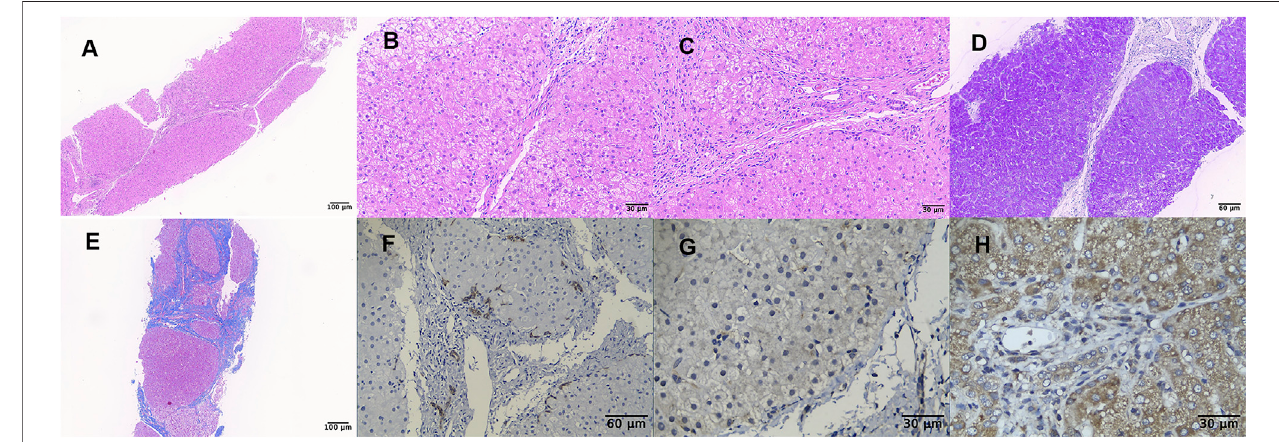
FIGURE 1 | Liver biopsy (all originally magni fi ed principal images). Hematoxylin and eosin staining showed the discorded architecture of liver lobules and the formation of pseudo-lobules (A×100) , ground-glass-like hepatic cells with lightly stained cytoplasm and obvious vesicular steatosis in portal area (B×400) , and lymphocytic in fi ltration in the portal area (C×400) . PAS staining identi fi ed small vacuoles in partial hepatocytes (D×200) . Formation of bridging-like fi brosis and pseudo-lobule was highlighted by Masson staining (E×100) . Mild hyperplasia of bile ducts along the margins of pseudo-lobule was showed by immunohistochemical stainingofCK7 (F×200) ,whileweakerstainingintheindexpatient (G×400) thaninnormalcontrol (H×400)